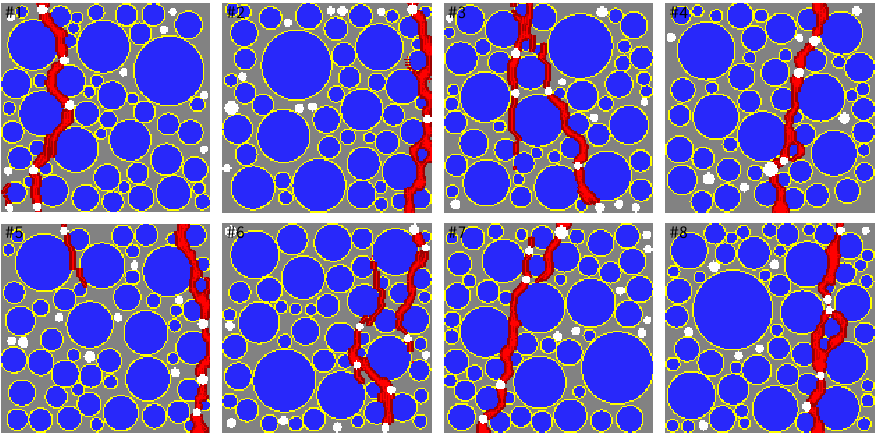
Figure 18. Crack pattern for selected specimens with P pore = 2% and P agg = 50%.